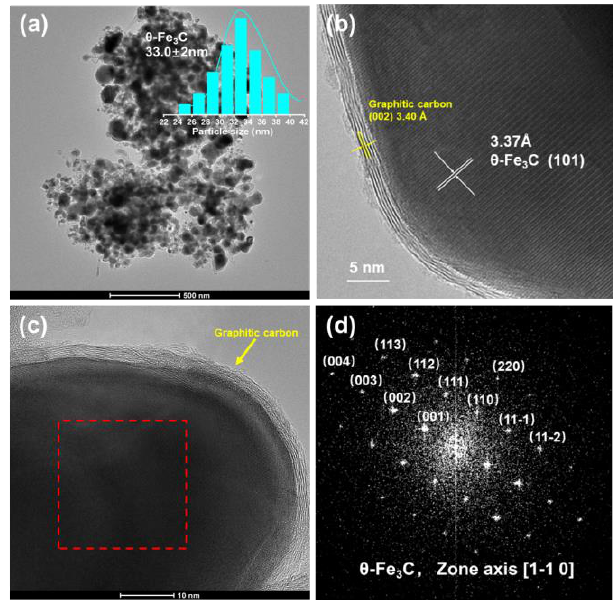
Figure 4. ( a – c ) TEM images of the prepared single-phase θ -Fe 3 C sample. Inset histogram in ( a ) represents size distribution of θ -Fe 3 C particles. ( d ) FFT image of the corresponding selected area marked with red square in ( c ).